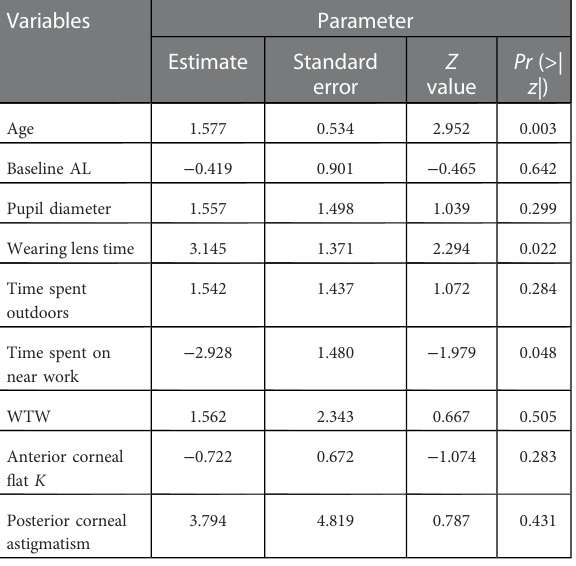
TABLE 3 Prediction model results using logistic regression.